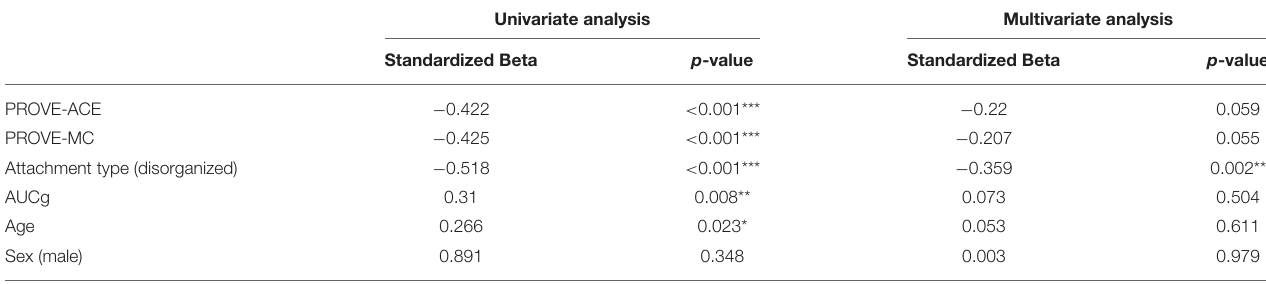
TABLE 2 | Linear regression analysis of resilience score in whole participants.